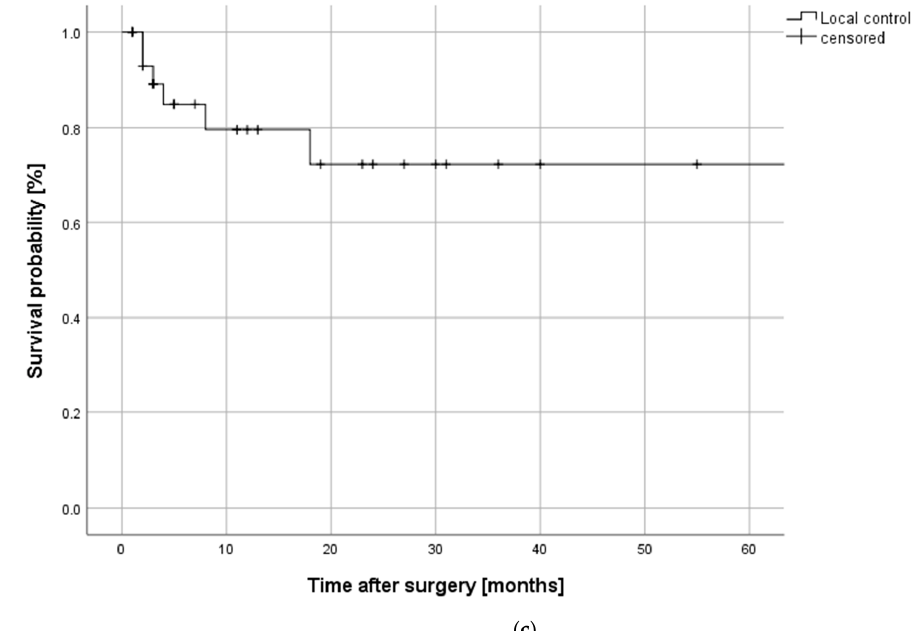
Figure 2. Kaplan–Meier curves depicting ( a ) overall survival, ( b ) progression-free survival, and ( c ) local control rate of the investigated cohort with full-thickness resections following advanced oral squamous cell carcinoma during a follow-up period of up to 60 months. Overall and progression-free survival rates exhibit a decrease to about 50% after 20–30 months, the local control rate shows a decrease to about 75% after 20 months.